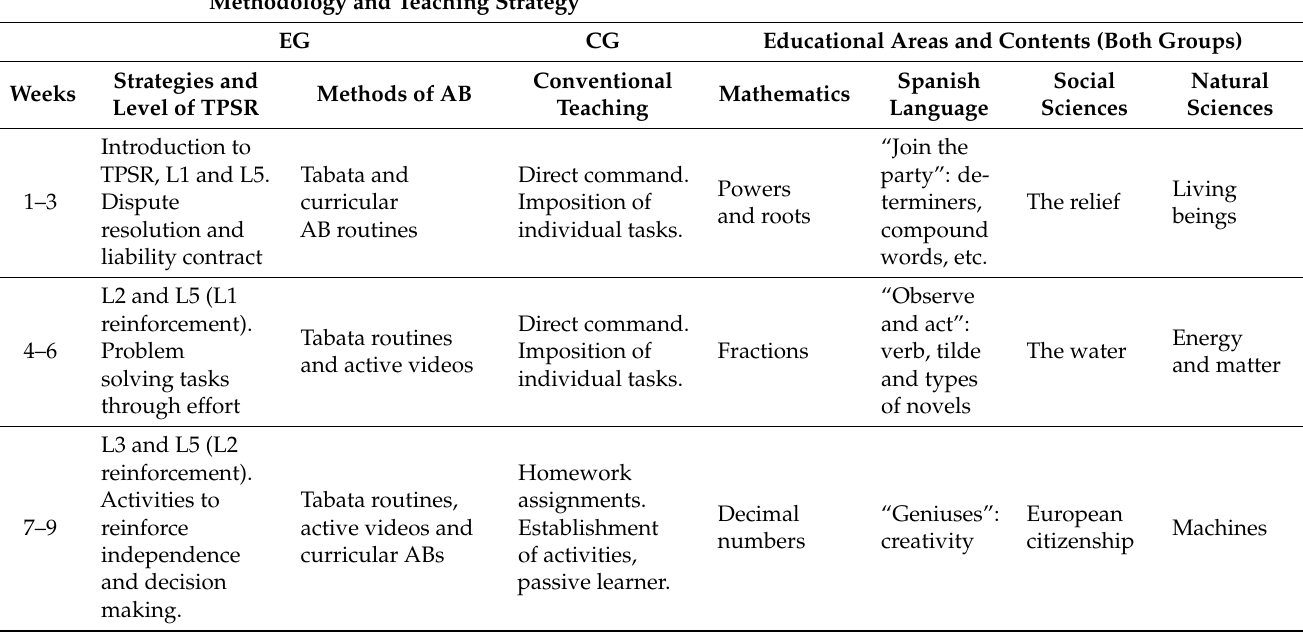
Table 2. Weekly content example and methodological strategies used by each